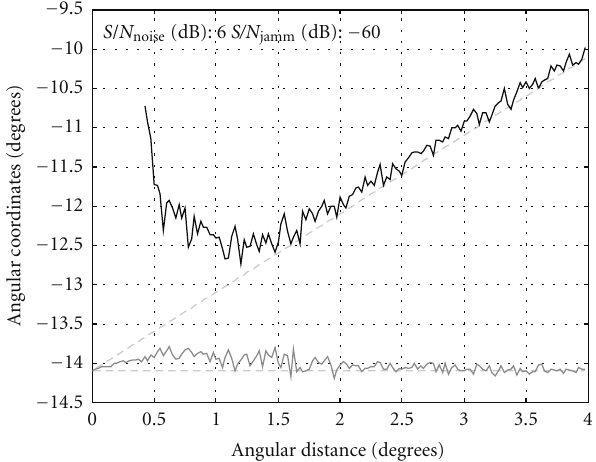
Figure 9: Histogram of polar coordinates evaluated by using the ESPRIT method at S/N noise = 6dB and S/N jamm = − 60 dB.